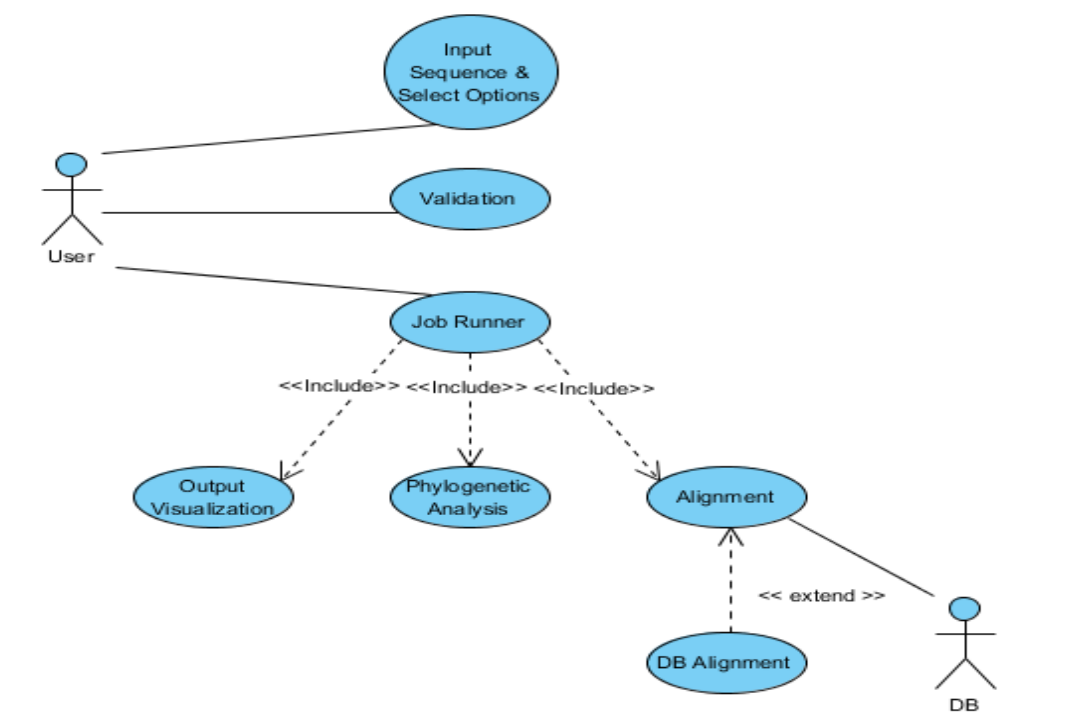
Figure 1. Use case diagram for the phylogenetic analysis module.